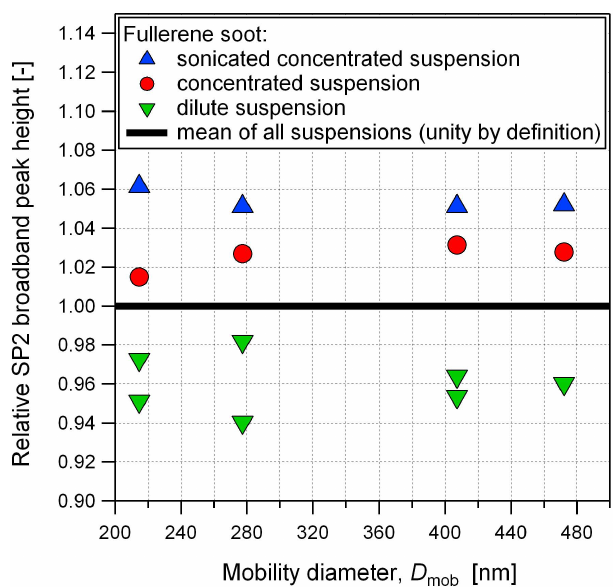
Fig. 5. Effect of different fullerene soot suspension treatments on the SP2 calibration based on particle selection by a DMA. The rela- tive SP2 broadband peak height is obtained by division of the broad- band peak height measured for a certain suspension by the mean value of the broadband peak heights measured for all suspensions at equal mobility